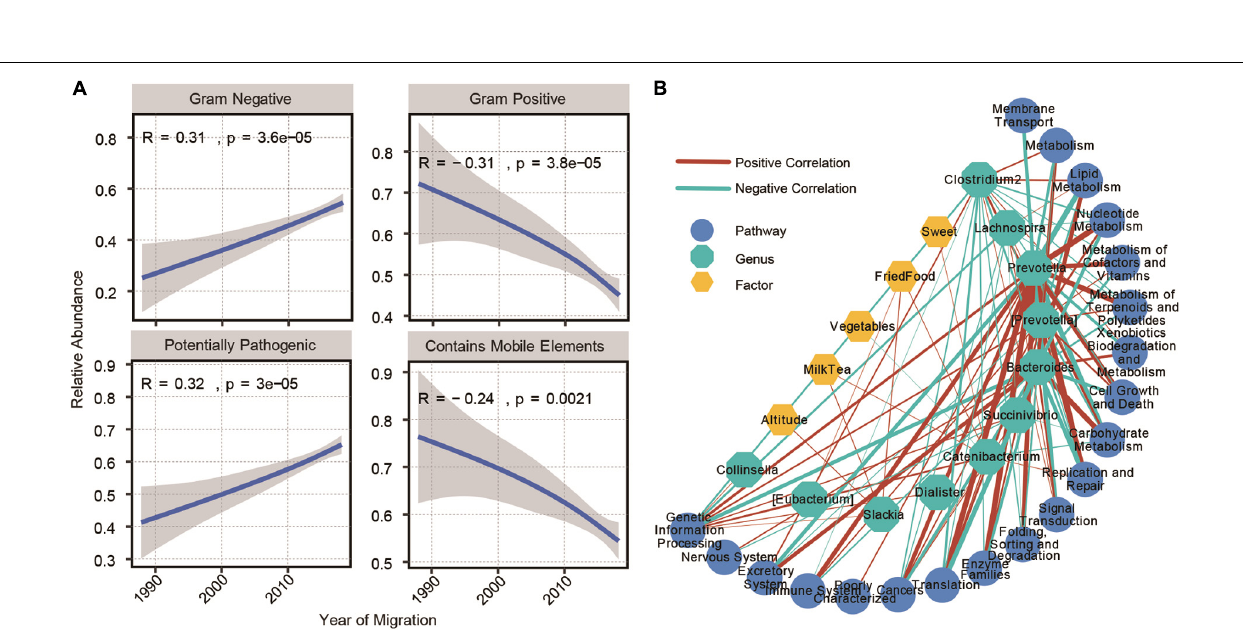
Frontiers in Microbiology |